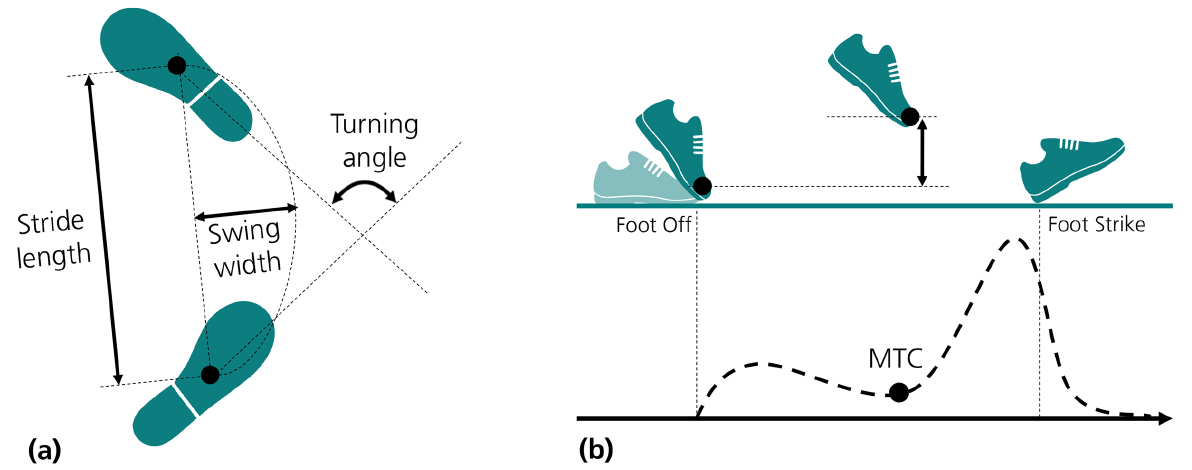
Figure 2. Illustration of spatial gait parameters: ( a ) Stride length, swing width and turning angle. ( b ) Minimum toe clearance